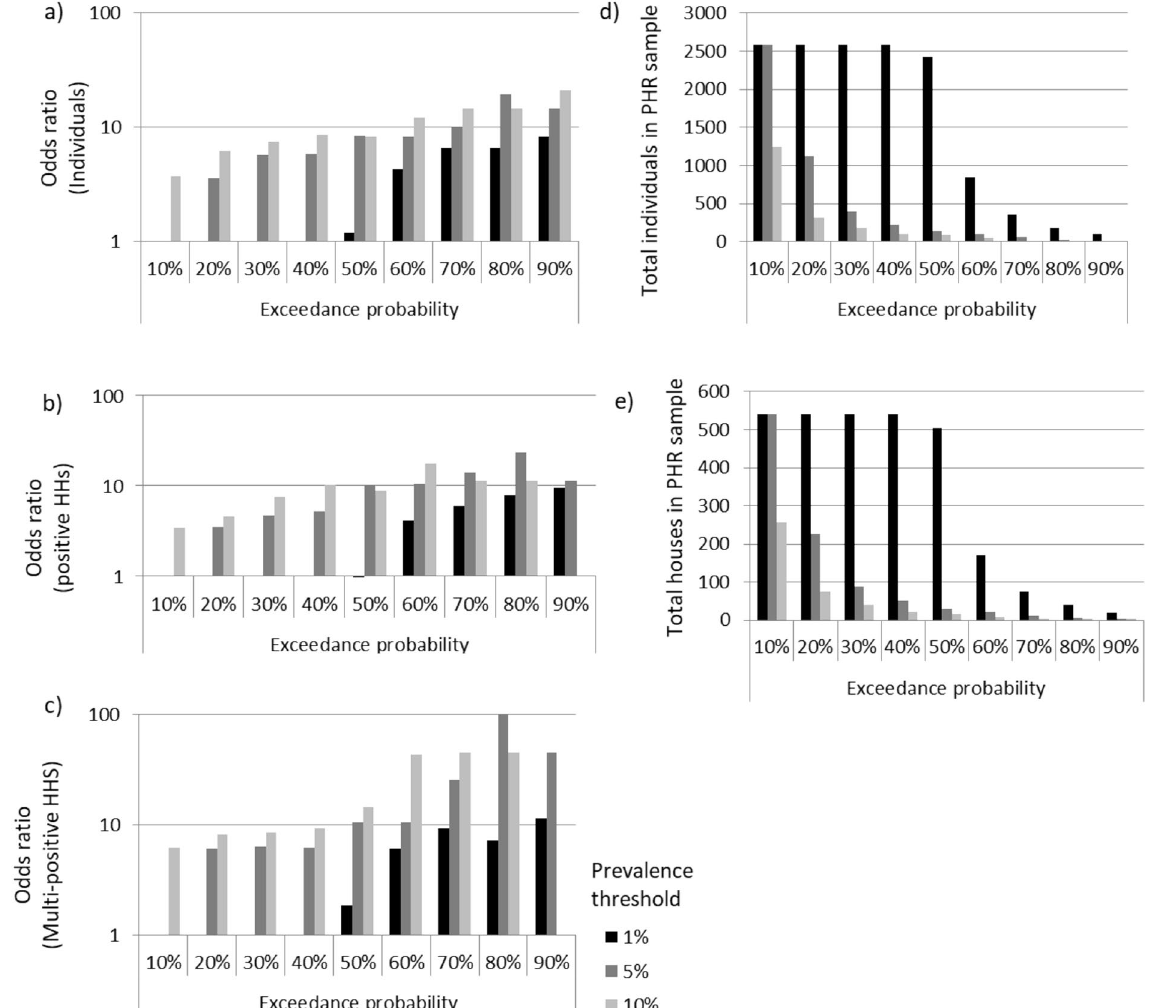
Figure 2. Odds ratios for ( a ) positive individuals, ( b ) positive households and ( c ) multi-positive households in predicted high risk compared to predicted low risk locations when stratified based on different combinations of prevalence thresholds (1%, 5%, 10%) and exceedance probabilities (10–90%). Values for predicted high risk definitions that had insufficient positive or multi-positive houses within either the predicted high risk or predicted low risk locations have been left blank. The number of ( d ) individuals and ( e ) households that were classified as being in a predicted location under each definition is also